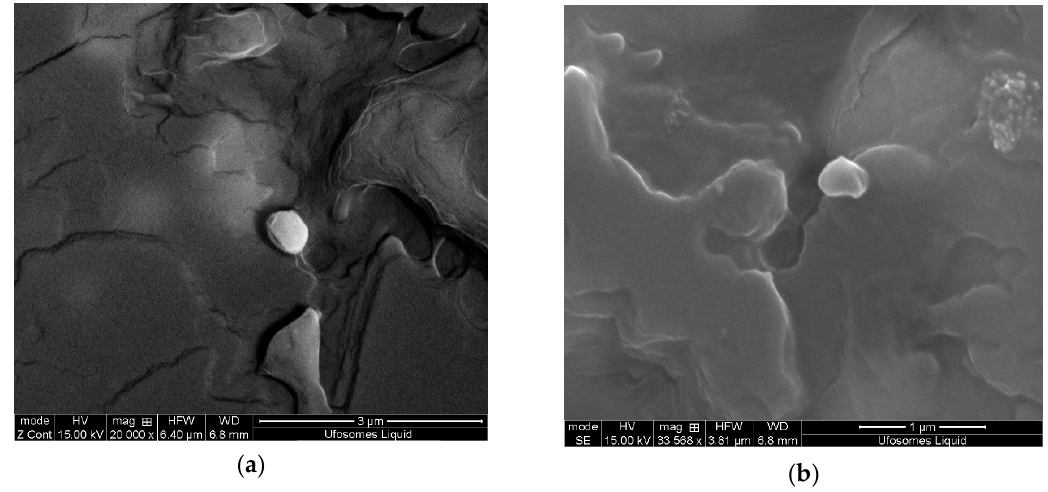
Figure 3. Scanning electron microscopy (SEM) images of clotrimazole loaded ufosomes (Ufo_6).